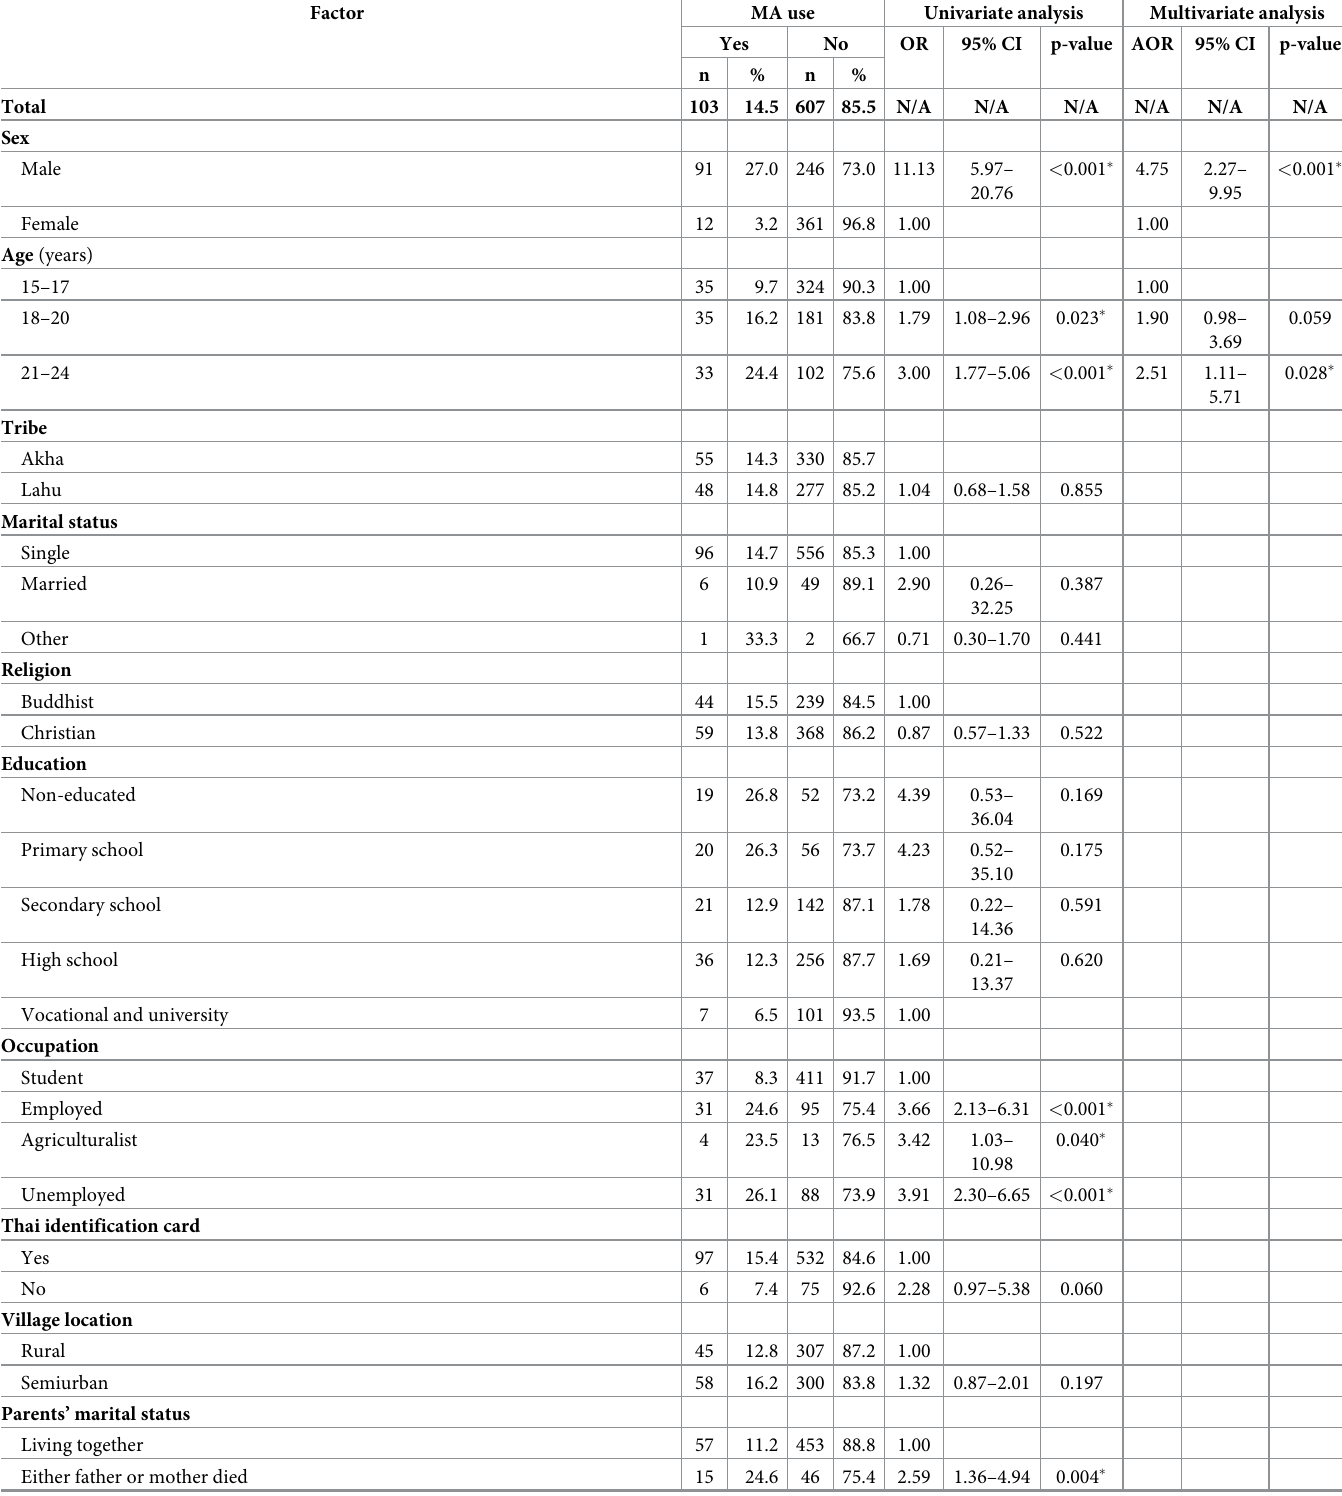
Table 6. Univariate and multivariate analyses of factors associated with MA use among Akha and Lahu